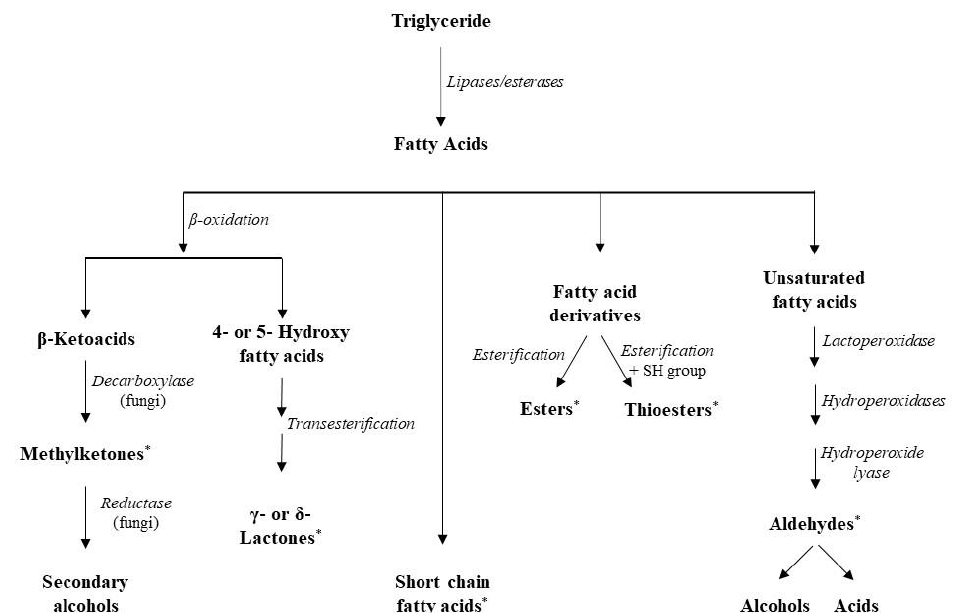
Figure 4. Schematic representation of fatty acids catabolism biochemical pathways leading to flavor compound formation in cheese. Asterisks denote potent flavor compounds [7,95,108,111].